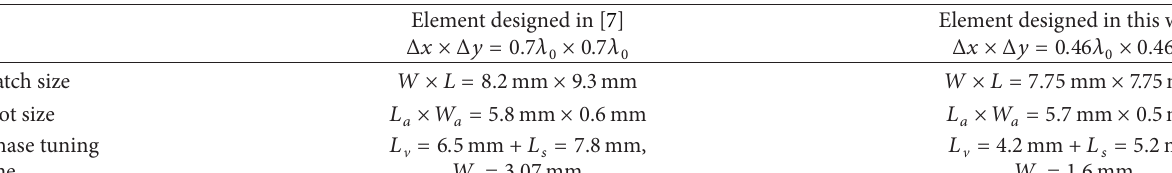
Table 2: Element dimension.